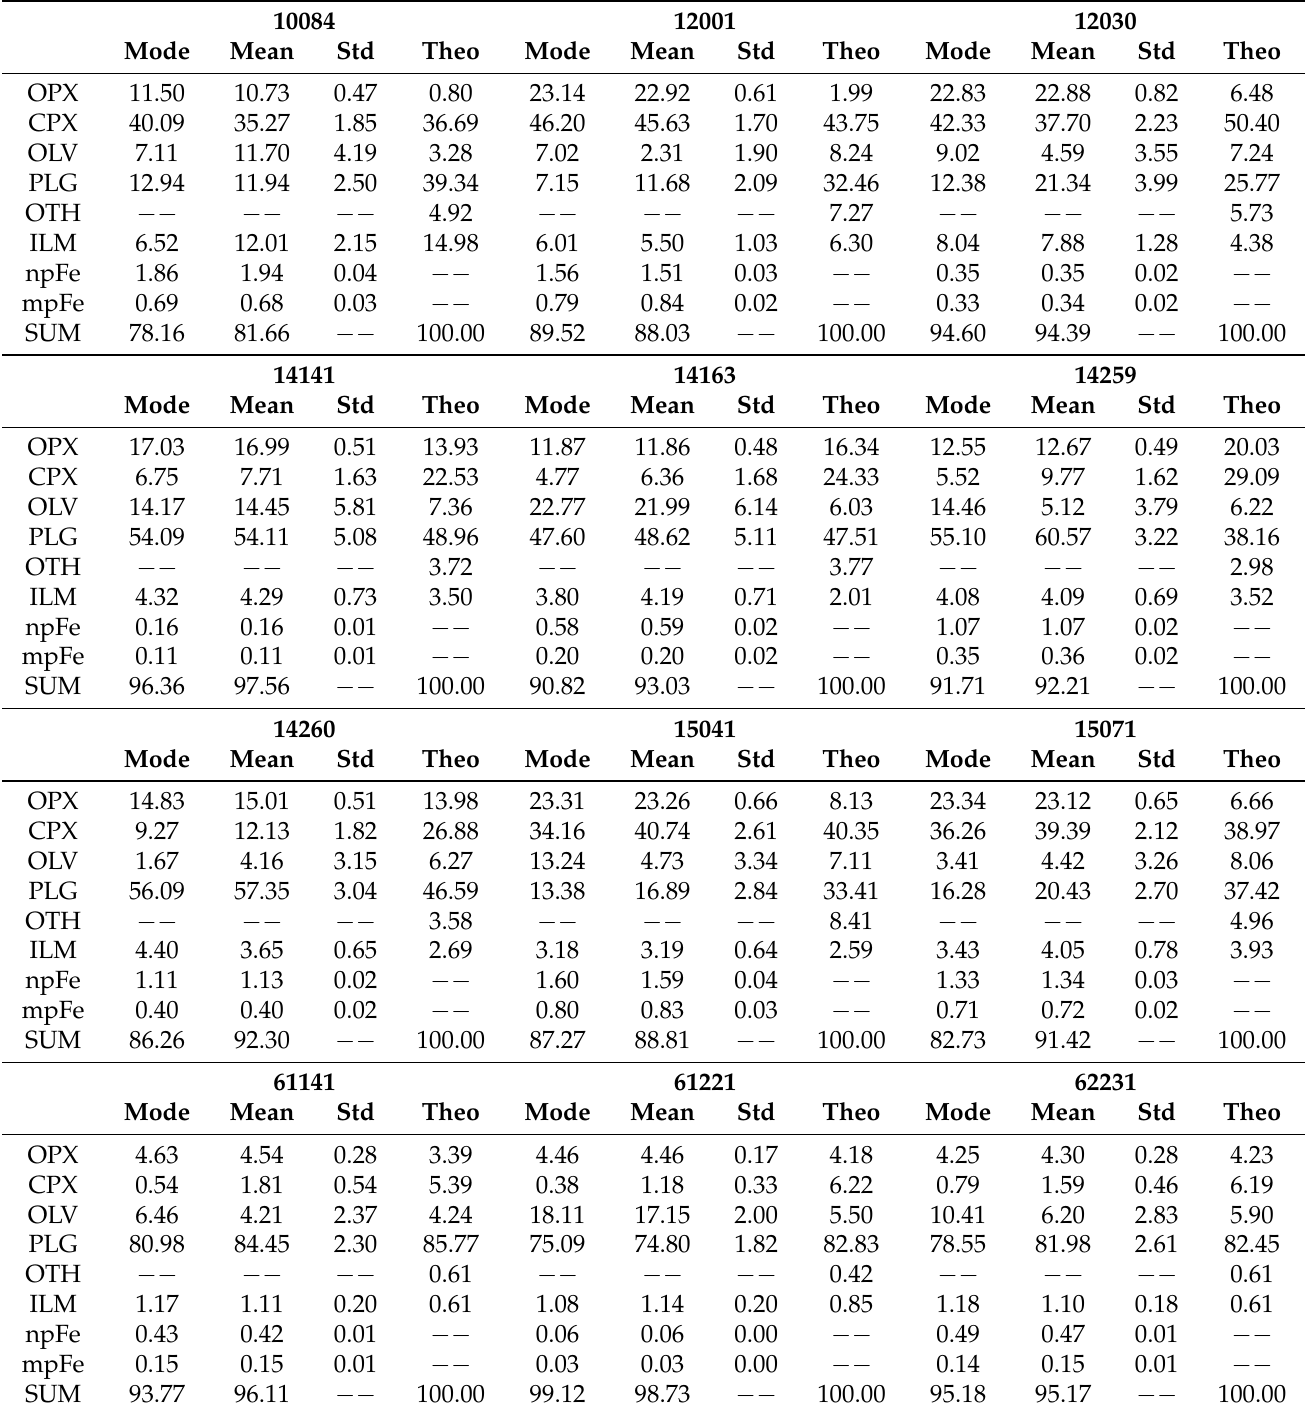
Table A10. Detailed results for the unmixing of LSCC spectra with the catalog of RELAB endmembers. A prior on the TiO 2 and the Al 2 O 3 was set with α elem =